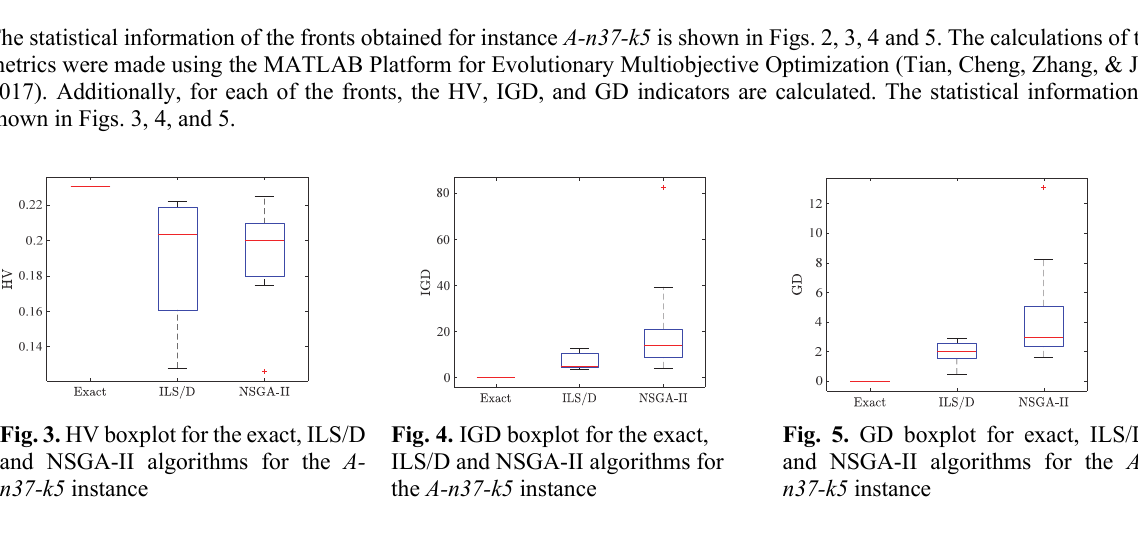
Fig. 1 . Exact Pareto front for the A-n37-k5 instance Fig. 2. Fronts obtained from the A-n37-k5 instance